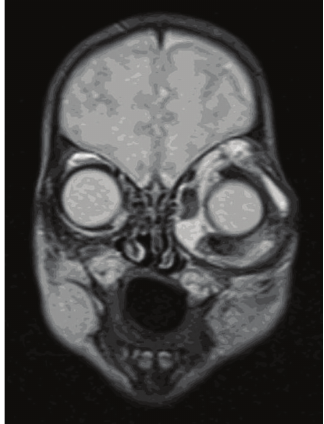
Figure 2: CT scan of initial presentation shows the large cystic mass was surrounding the globe and stretching the extraocular muscles in the left orbit. The right eye appears normal.